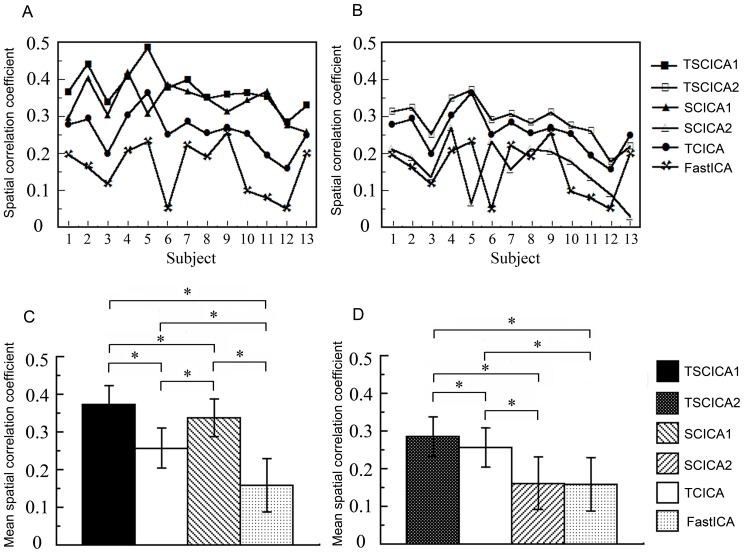
A comparison of TSCICA, TCICA, SCICA and FastICA.(A) The spatial correlation coefficient of TSCICA1, TCICA, SCICA1 and FastICA for an individual subject. (B) The spatial correlation coefficient of TSCICA2, TCICA, SCICA2 and FastICA for an individual subject. (C) The mean spatial correlation coefficients of TSCICA1, TCICA, SCICA1 and FastICA. (D) The mean spatial correlation coefficients of TSCICA2, TCICA, SCICA2 and FastICA. The error bar represents the standard deviation. TSCICA1/SCICA1 represents TSCICA/SCICA using the first spatial reference. TSCICA2/SCICA2 represents TSCICA/SCICA using the second spatial reference. The error bar represents the standard deviation. Note: asterisk represents P<0.01.